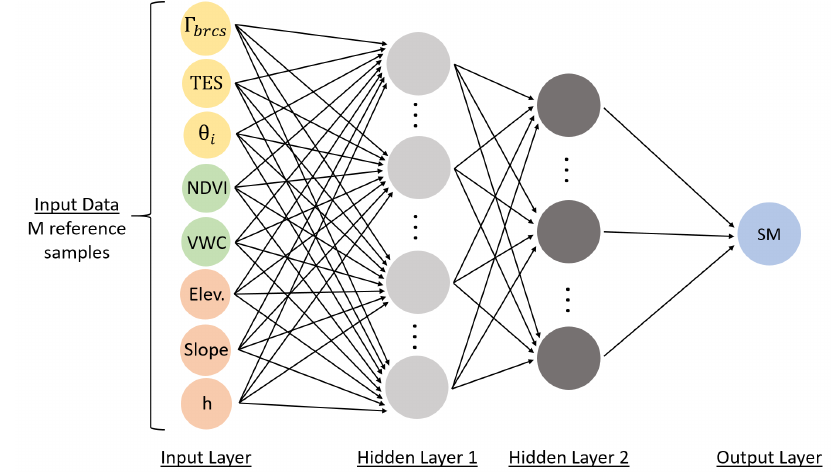
Figure 2. Artificial Neural Network with two hidden layers. Input features and the output node are color-coded with respect to separate data sets from which the parameter values were derived. ( Γ brcs is the reflectivity calculated from BRCS and will be defined